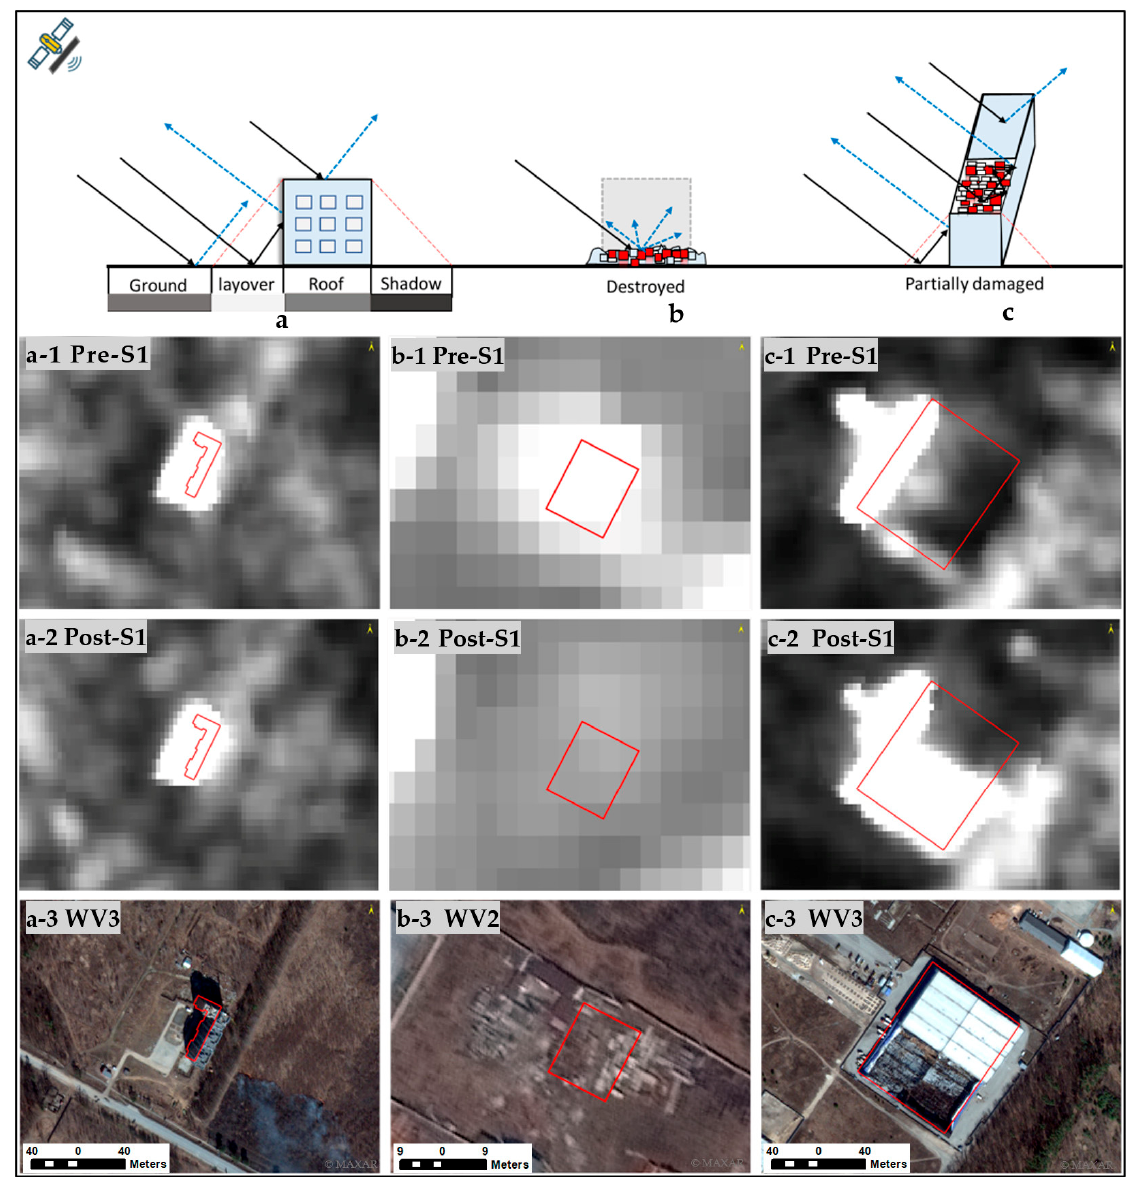
Figure 5. Schematic diagram of backscatter intensity from ( a ) intact buildings ( b ) destroyed buildings, and ( c ) partially damaged buildings in synthetic aperture radar (SAR) images; ( a-1 , a-2 , b-1 , b-2 , c-1 , c-2 ) are pre-and post-event Sentinel-1 images (19 February 2022 & 8 April 2022); ( a-3 , b-3 , c-3 ) are corresponding WorldView images (25 & 31 March 2022).